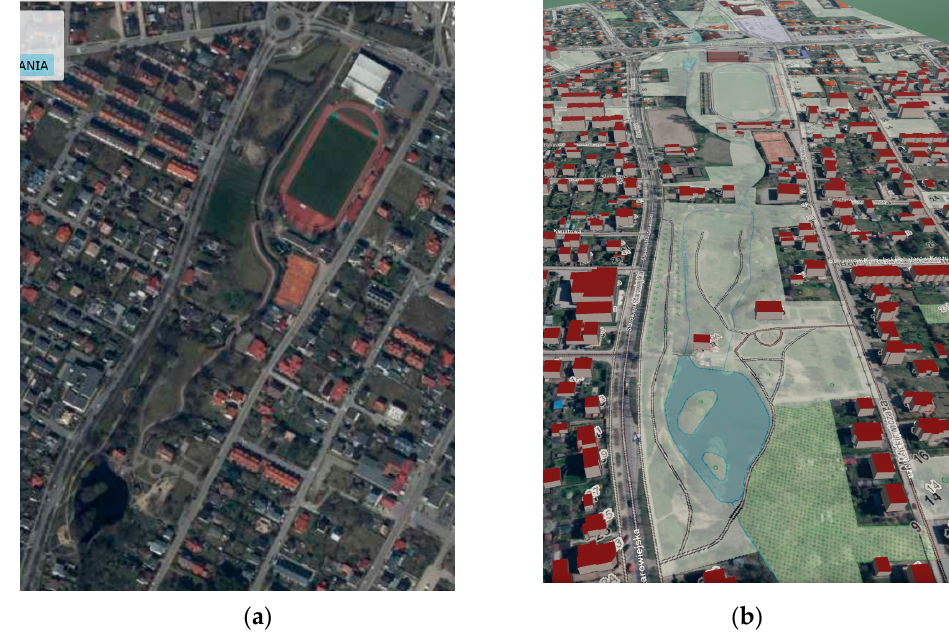
Figure 2. Park Starowieski on orthophotomaps, 2021 ( a ) aerial photo, ( b ) 3D map source: [12].